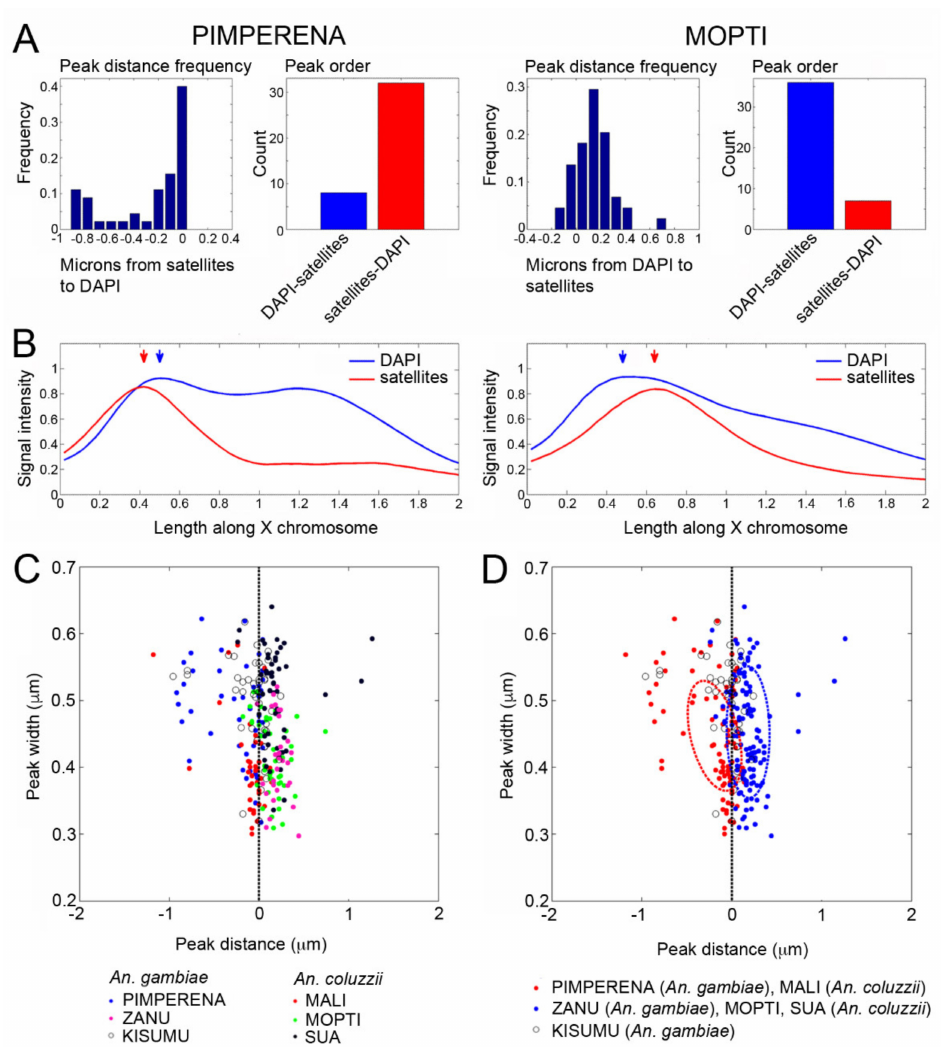
Figure 6. Polymorphism of the X heterochromatin structure among the An. gambiae and An. coluzzii strains. ( A ) Distance and order frequency of FISH signal and DAPI band intensity peaks in An. gambiae PIMPERENA and An. coluzzii MOPTI. ( B ) Distribution patterns of signal intensities for satellites and DAPI along the X chromosomes in An. gambiae PIMPERENA and An. coluzzii MOPTI. ( C ) Relative positions of satellite peak distance and width with respect to the proximal heterochromatin band for six strains of An. gambiae and An. coluzzii . ( D ) Clustering of the An. gambiae and An. coluzzii strains based on the relative positions of satellite peak distance and width with respect to the proximal heterochromatin